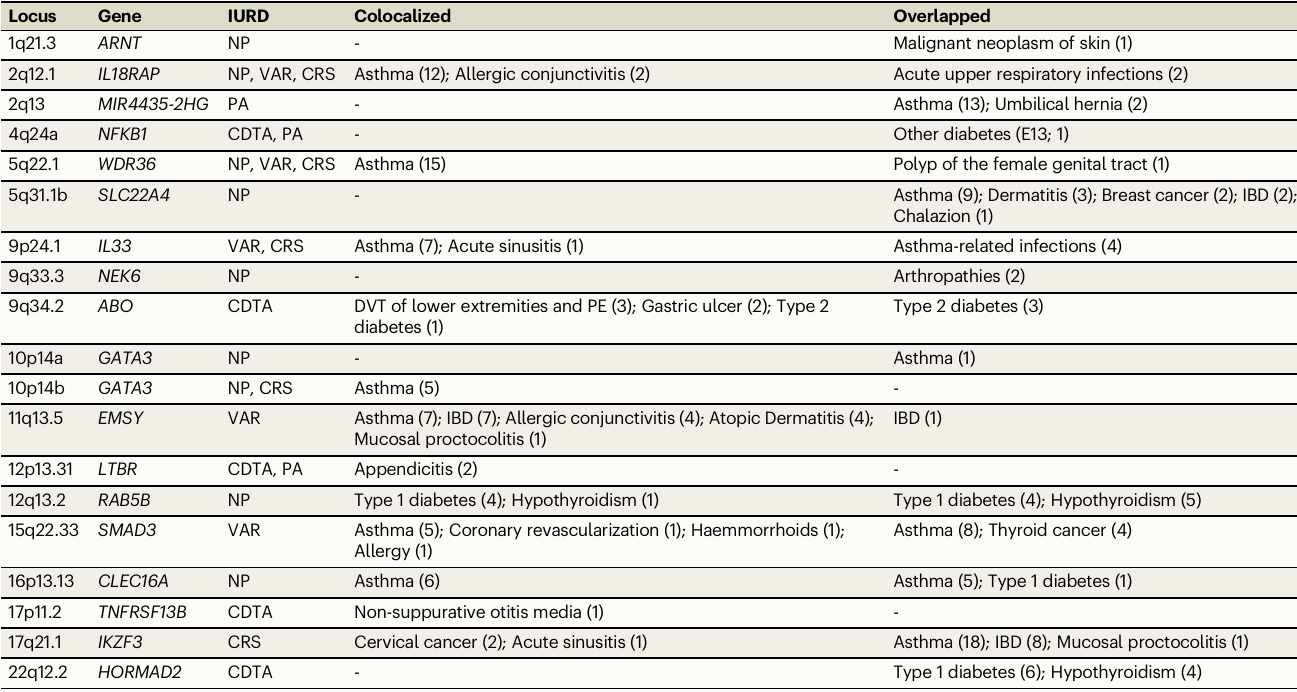
Table 6 | IURD genomic loci credible sets shared with other FinnGen endpoints